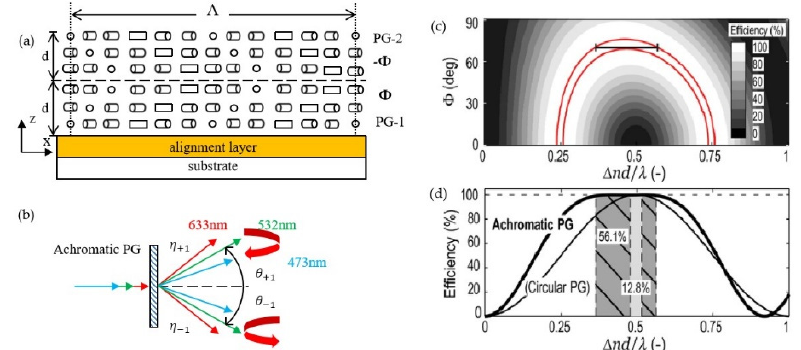
Figure 4. (a) Schematic drawing of the opposite twisted dual-layer achromatic polarization gratings (side view); (b) Schematic drawing of the diffraction geometry of the achromatic PG (linear polarized incident); Theoretical diffraction efficiency of the achromatic PG; (c) First-order efficiency spectra versus twist angle and (d) for Φ = 70° compared with the circular PG [23]. Reprinted with permission from [23] © The Optical Society.